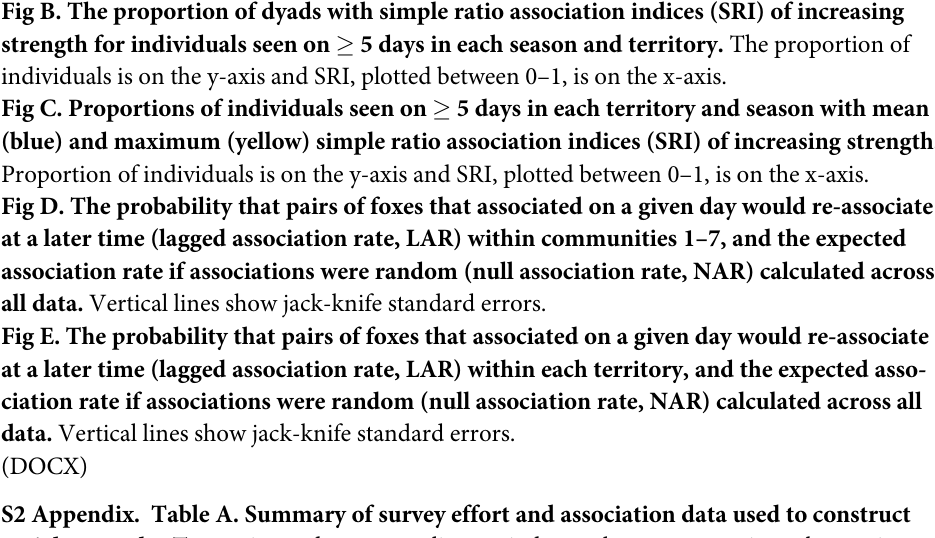
Table B. Results of the Manly/Bejder tests for preferred and avoided companions for the combined dataset and separately for each territory and season network. Dashes indicate degenerate networks that were too sparse to permute. � indicates the p -value was close to sig- nificance (0.1 > p > 0.05). Table C. Parameter estimates and interpretation of the best-fitting exponential decay models fitted to lagged association rates (LARs) for the whole dataset and separate sea- sons, communities and territories. Standard errors were estimated by jack-knifing over one day. The models with the lowest QAIC each contained proportions of rapid disassociations (RD), preferred companions (PC) and casual acquaintances (CA) of one or two types, defined in the formulae as a1-a4. Lag = time lag in days. The top two models are presented for autumn as Δ QAIC < 2. AR indicates the probability of re-association after given time lags in days. Table D. Mantel test correlations ( R ) between seasonal association matrices with the mean p -value and standard deviation (SD) calculated from three runs each with 10,000 permuta- tions. Season pair denotes the two surveys compared, listed in the order of data collection: spring (SP), summer (SU), autumn (AU) and winter (WI). Time between seasons indicates how close in time the compared surveys were: 1 = consecutive, 2 = gap of one season and 3 = gap of 2 seasons. Significant p -values ( p < 0.05) and those close to significance (0.1 > p > 0.05, marked with � ) are shown in